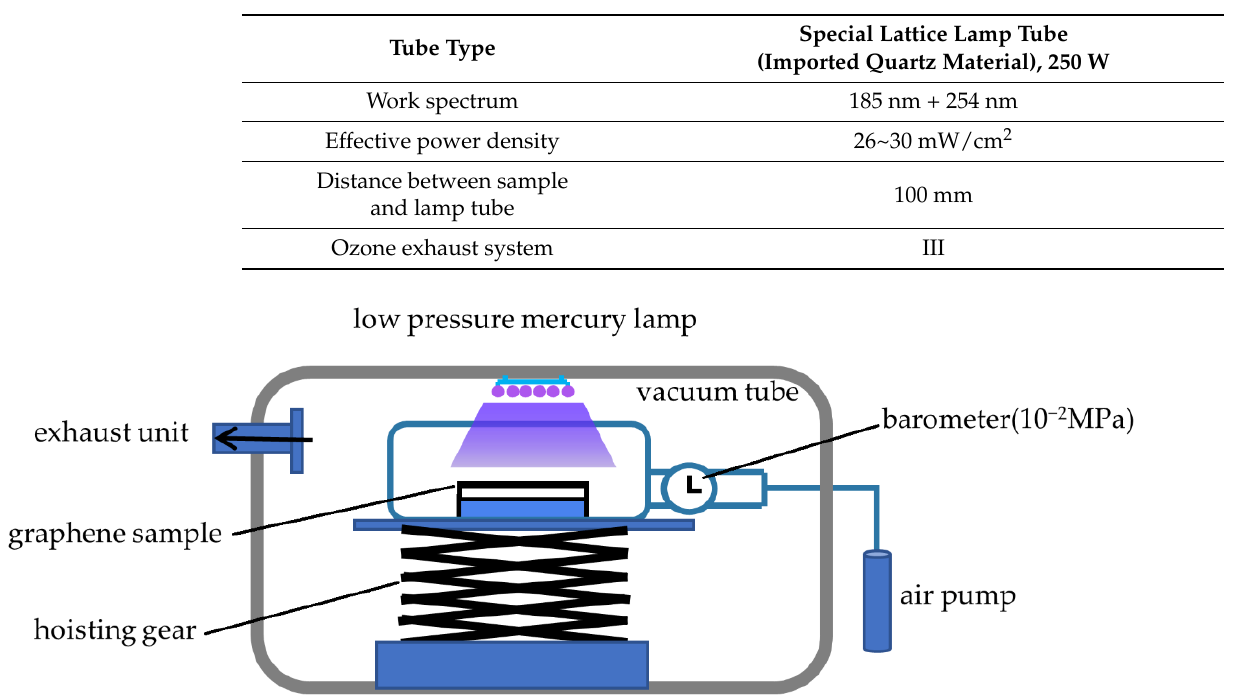
Table 1. Experimental parameters of BZS250GF-TS UV radiometer.